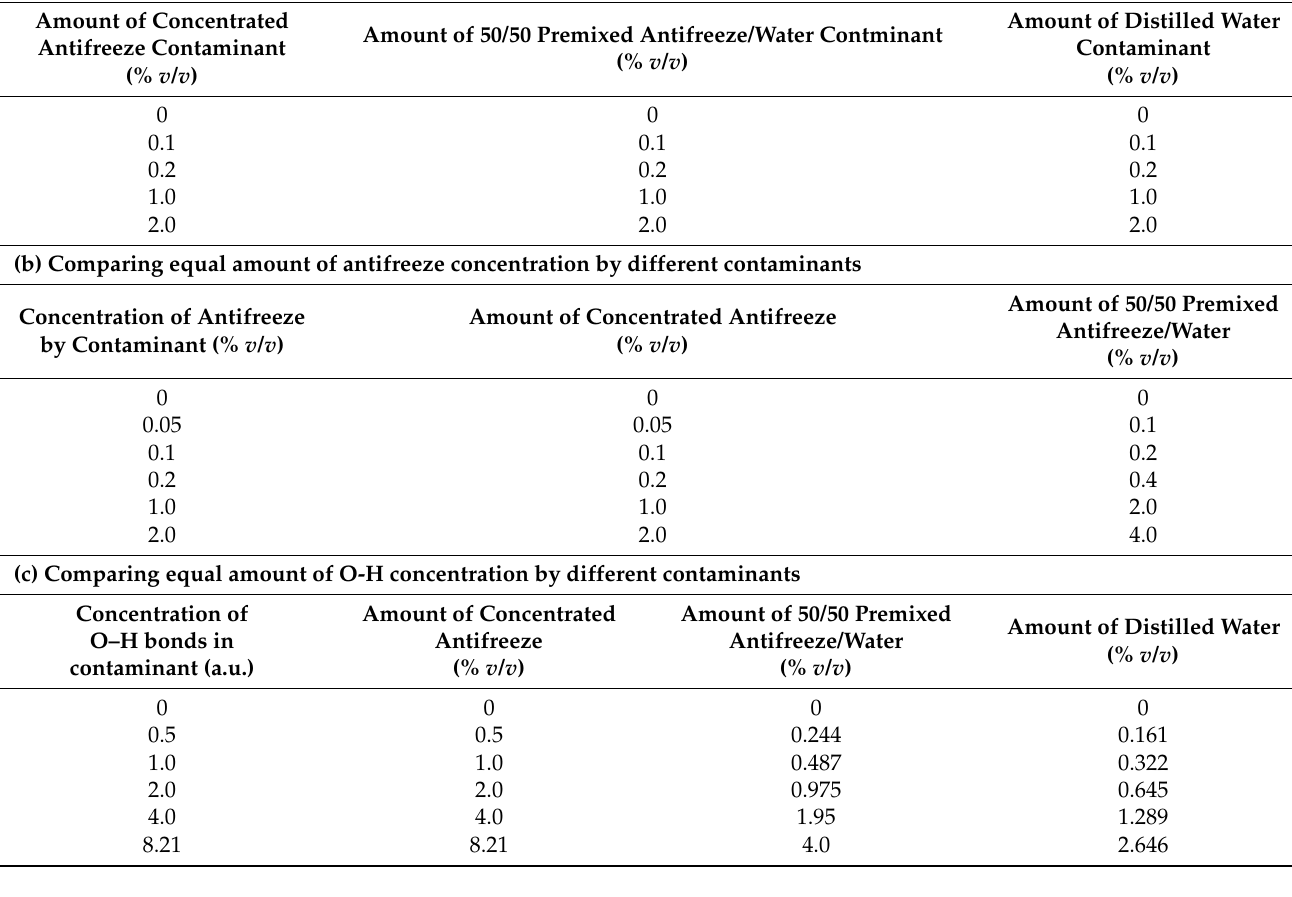
Table 1. (a) The three different contaminant types are listed by the total percent volume of the contaminant in the oil samples for the purposes of comparing equal volumes of the different con- taminants; (b) The concentrated antifreeze and the 50/50 premixed antifreeze samples are listed by the total percent volume of the contaminant that corresponds to the percent volume of concentrated antifreeze that contaminates the oil samples for the purposes of comparing the equal amount of antifreeze concentration by different contaminants; (c) The three different contaminant types are listed by percent volume of contamination corresponding to an equal number of O–H bonds per cubic centimeter as normalized to those found in the concentrated antifreeze sample for the purposes of comparing equal amounts of O–H concentration by different contaminants. The normalization procedure is discussed in Section